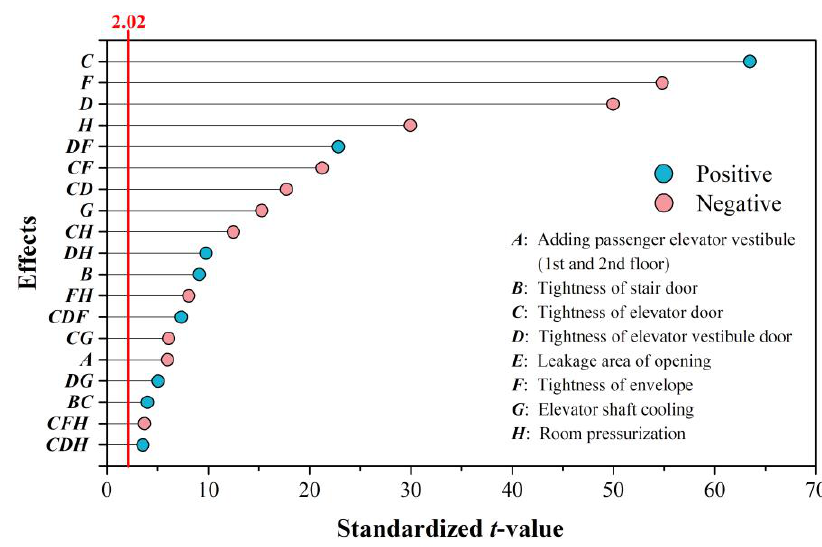
Figure 9. The maximum pressure difference at 21st floor elevator doors: Pareto effect plot.